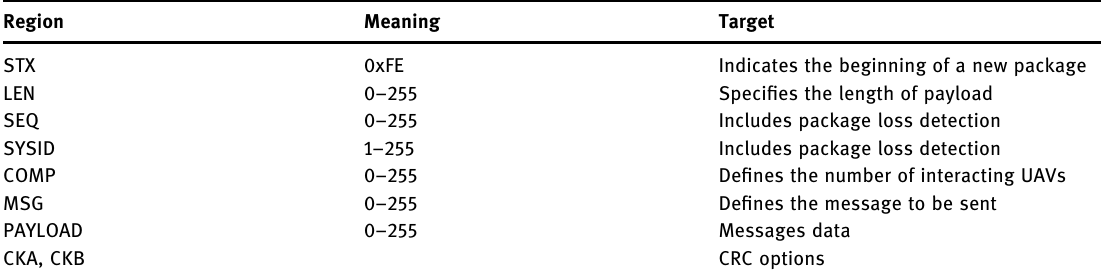
Table 1: Details of the MAVLink